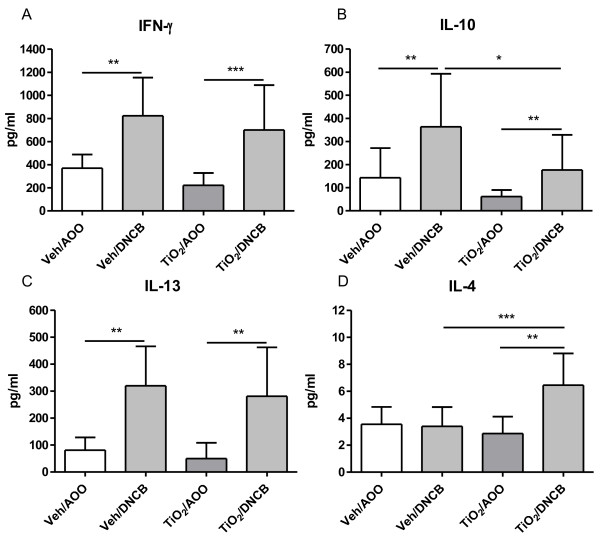
Lymphocyte cytokine production after 0.1% DNCB dermal sensitization or AOO treatment with prior injection of 0.04 mg/ml TiO2 or vehicle. On day 5, the auricular lymph nodes are removed and lymphocytes are cultured for 42 h in the presence of ConA. Cytokines are determined in LNC supernatant. Graphs show mean ± SD, n = 10–12, *p < 0.05, ** p < 0.01 and *** p < 0.001.